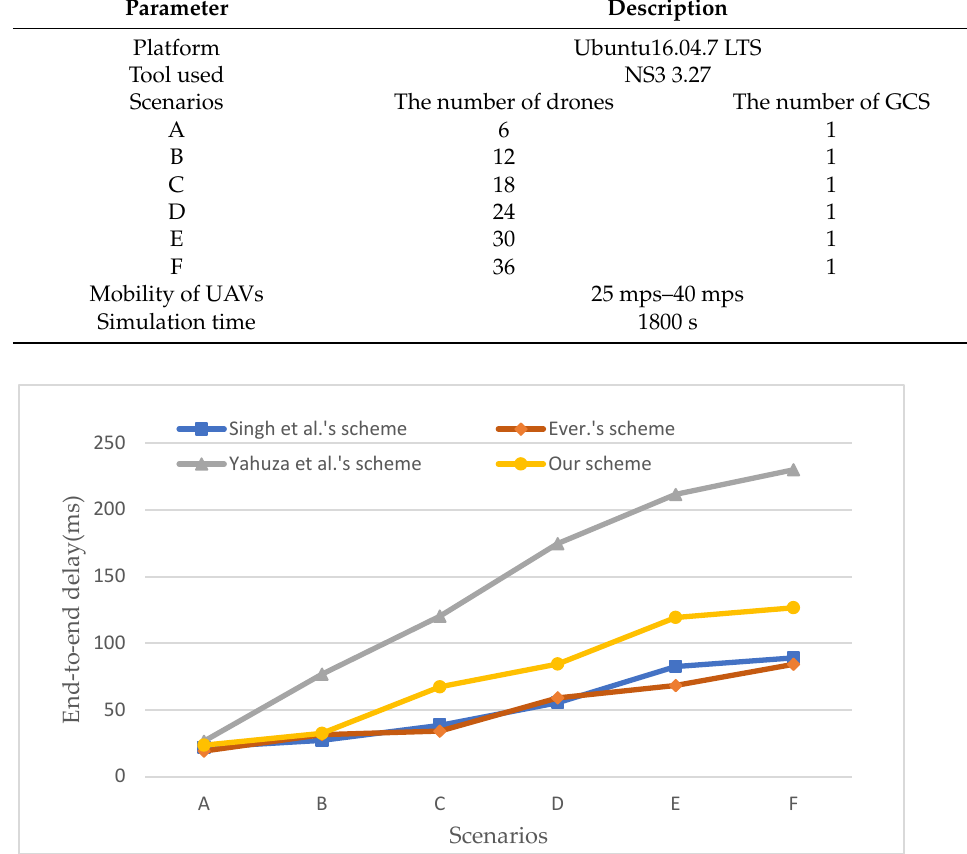
Figure 10. Comparison of end-to-end delays among different schemes [31–33].